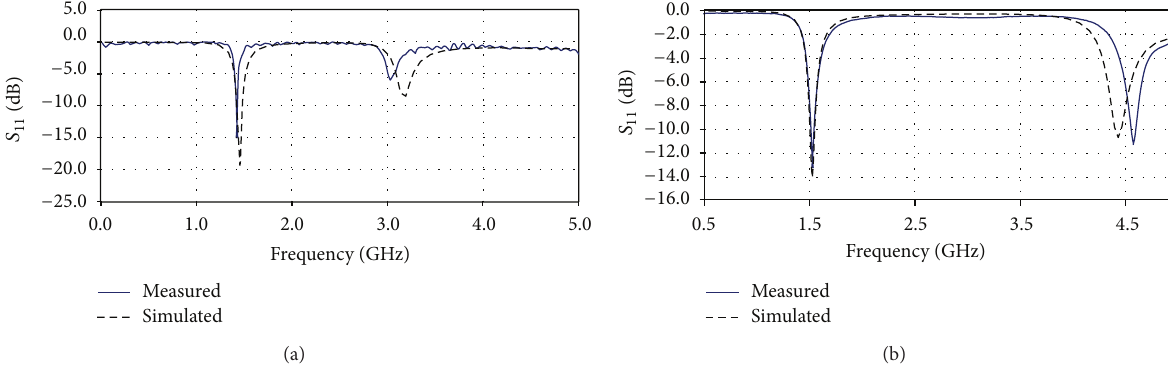
Figure 13: Comparison of simulated and measured 𝑆 11 parameter, (a) IFA and (b) PIFA.